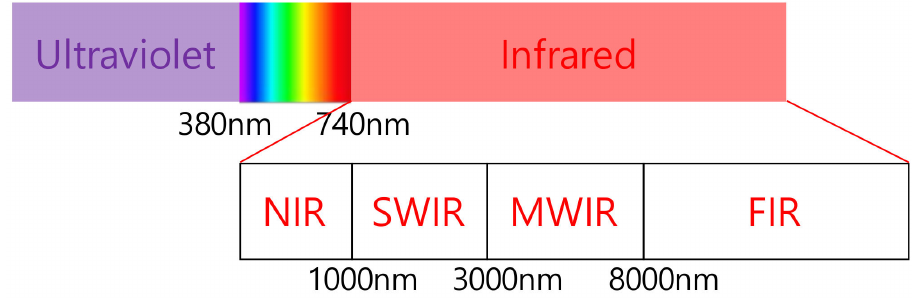
Figure 2. Infrared light